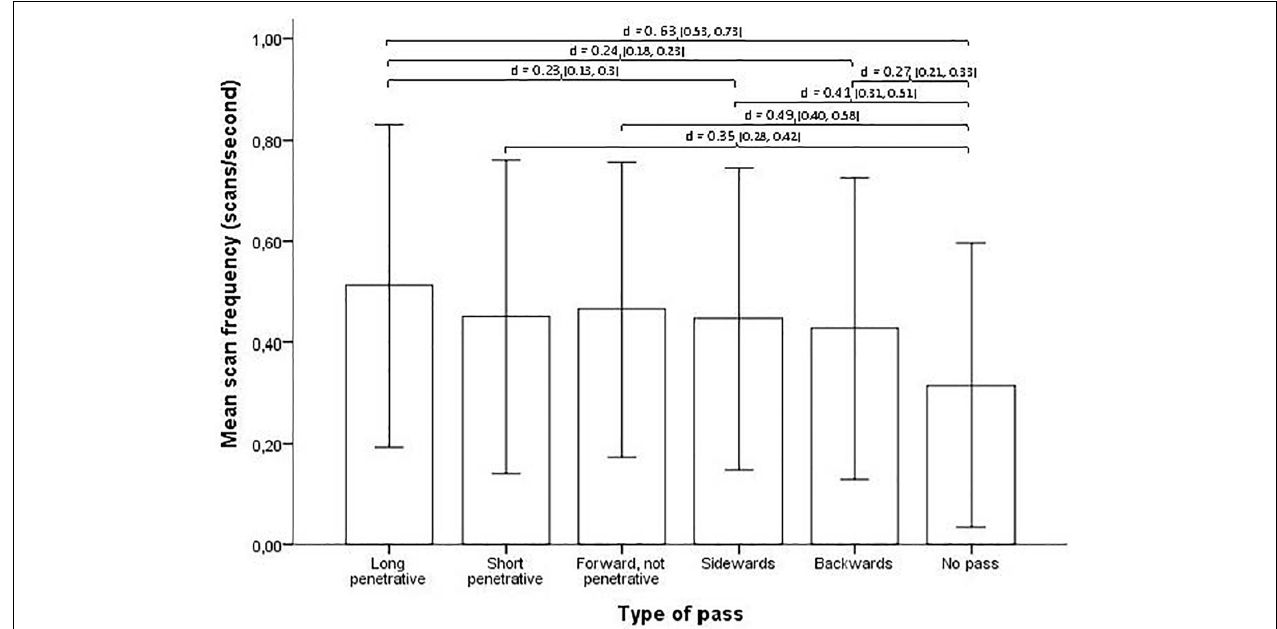
FIGURE 6 | Type of pass and Mean scan frequency (with SD error bars). Brackets indicate all significant relationships with an effect size > 0.20, with effect size d and the 95% confidence interval (CI) in